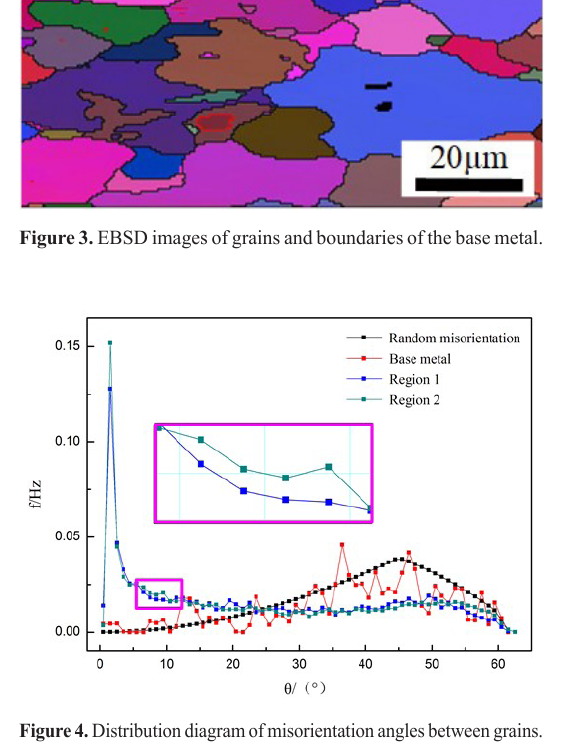
Figure 4. Distribution diagram of misorientation angles between